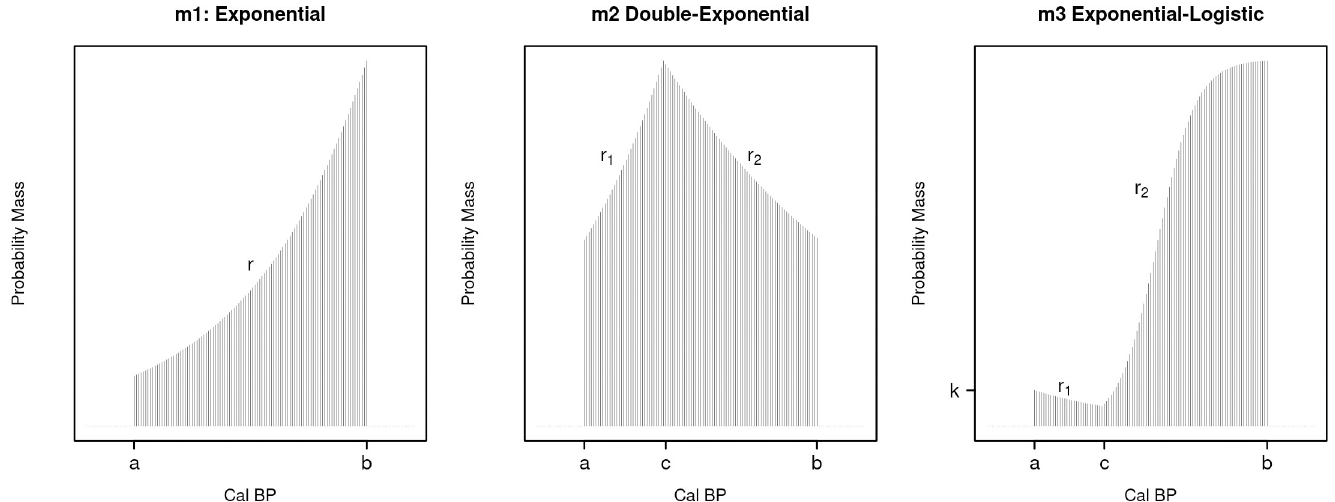
Fig 2. Models m1, m2, and m3 with associated